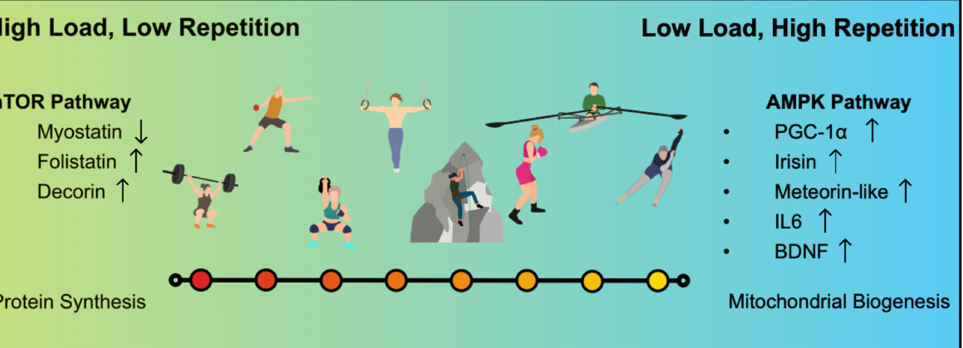
Figure 2. The Strength–Endurance Continuum shows exemplarily different types of sports, associated with strength training. In general, there is not only weightlifting, but also other kinds of strength training that lead to the health promoting